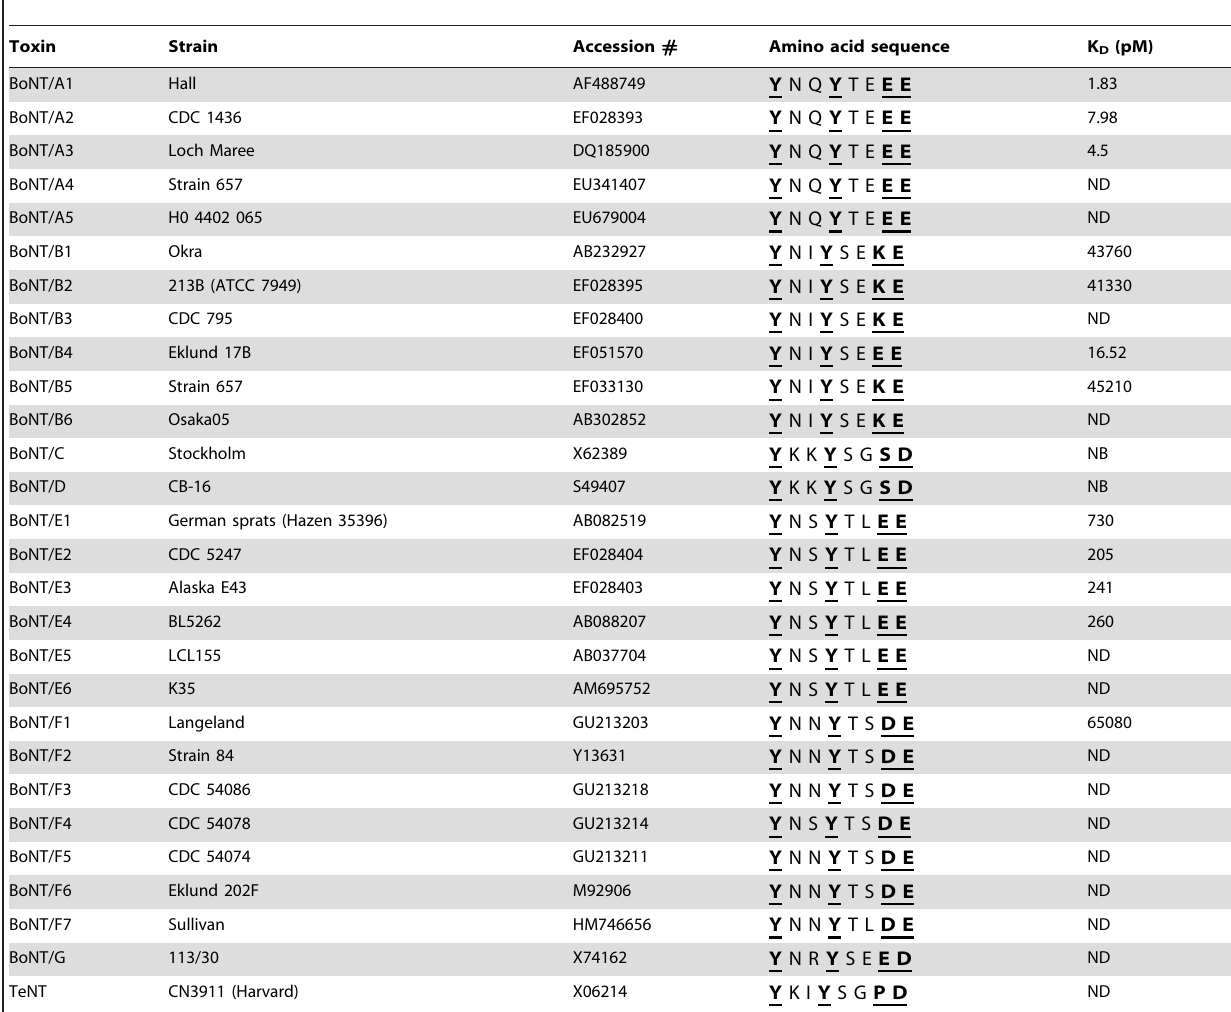
Table 2. Sequence alignment of known BoNT subtypes in the range of Y750 to E757 of